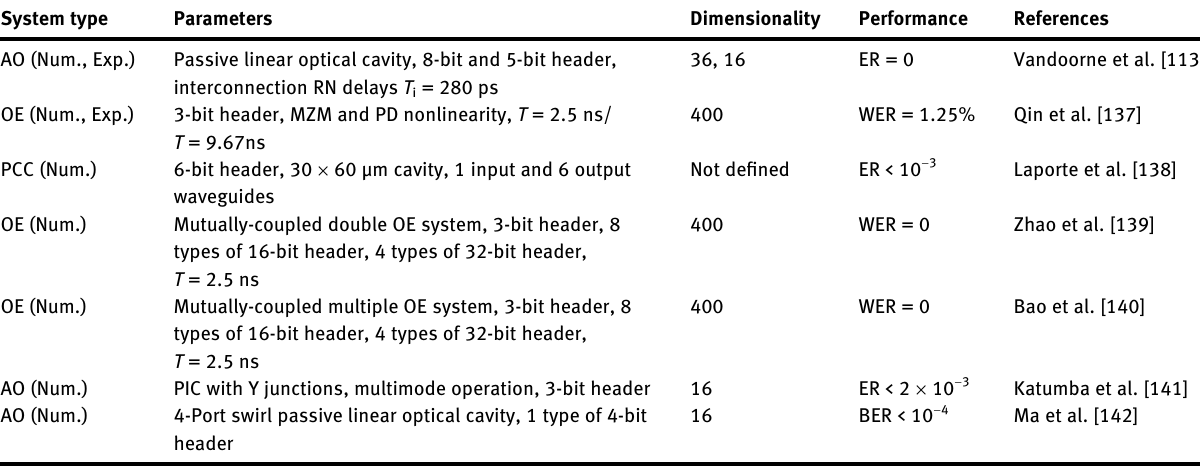
Table  : Photonic neuromorphic systems based on RC applied on the optical header recognition task. PCC: photonic crystal cavity. System